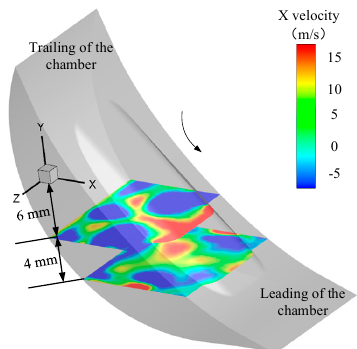
Figure 3. Location for comparison at 135° BTDC.